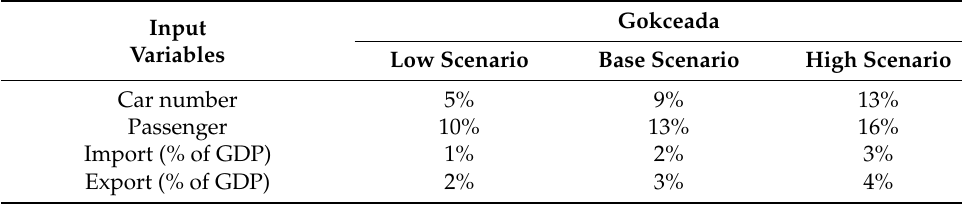
Table 2. Gokceada Island scenarios input values and assumptions.